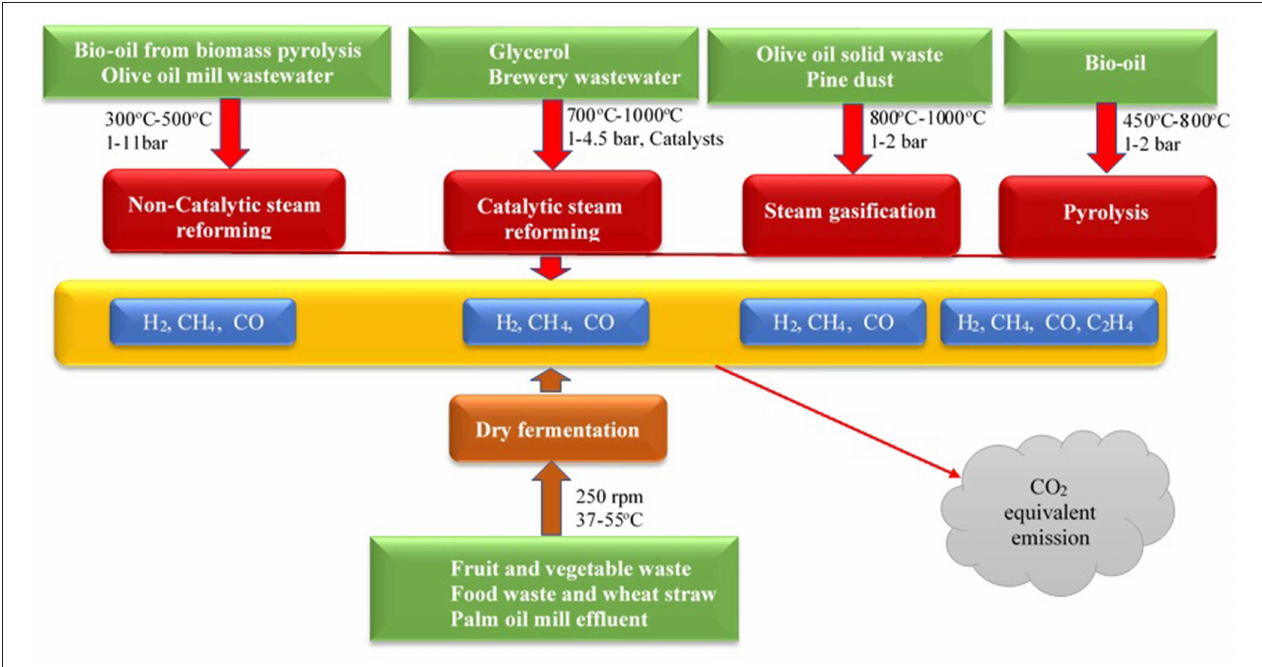
FIGURE 1 | An overview of various thermo-catalytic and fermentative processes used for hydrogen-rich syngas production.